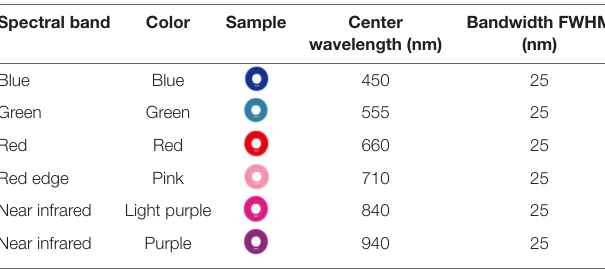
TABLE 1 | Center wavelength and full width at half maximum (FWHM) bandwidth of each spectral band of the multispectral camera. Spectral band